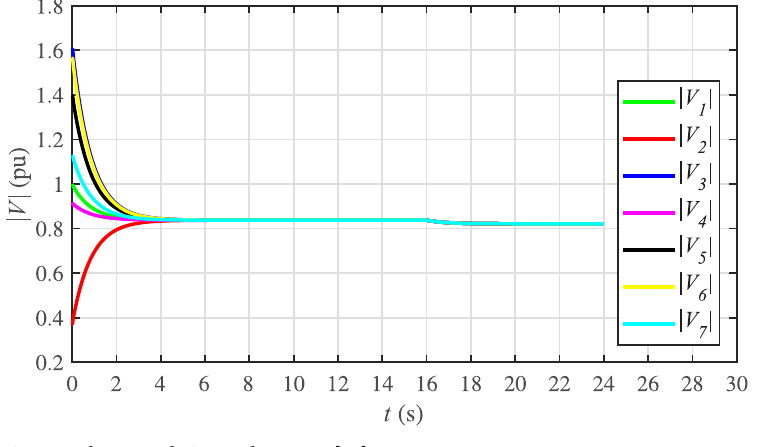
Fig 44. Voltage regulation under case 5. [27].